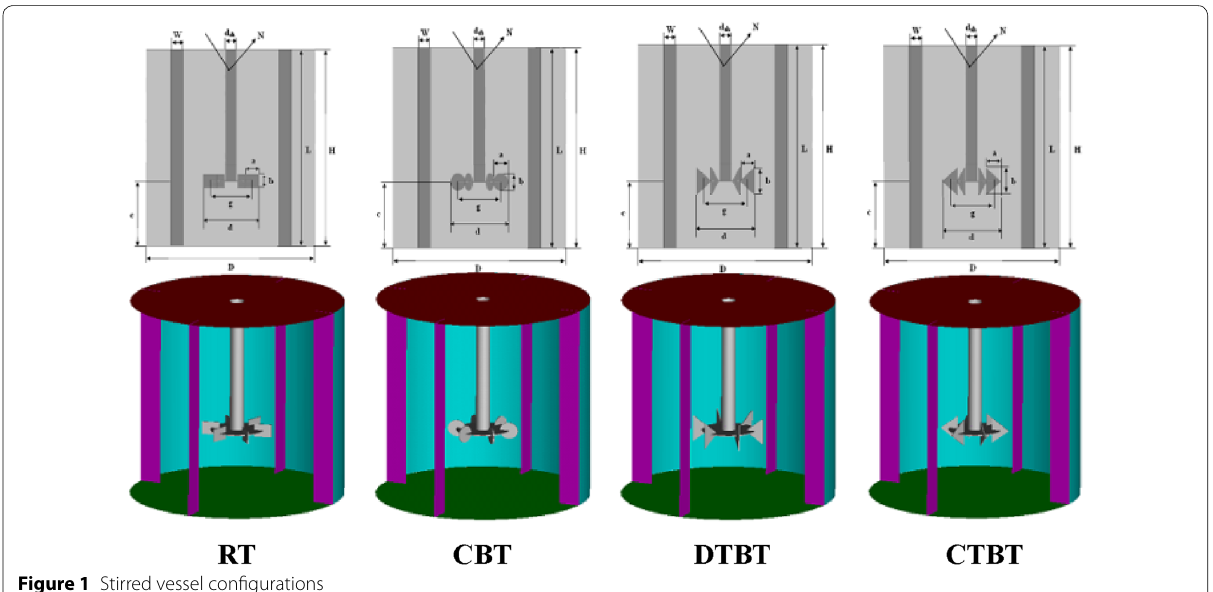
Figure 1 Stirred vessel configurations